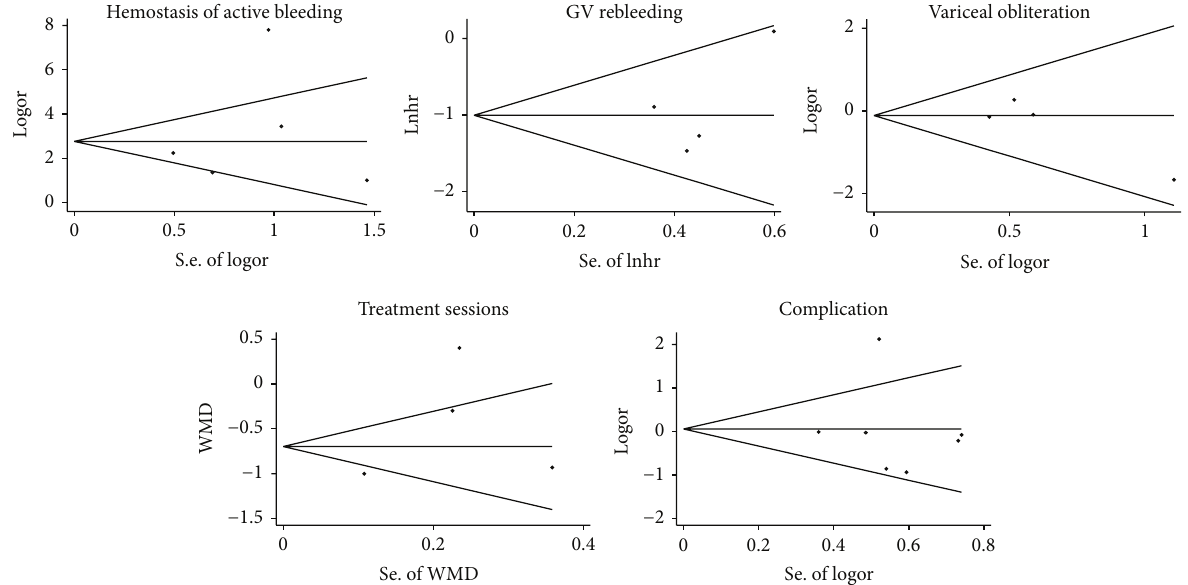
occurred more frequently with GVL than with GVO in all patients and in the subgroup of GOV1 patients.